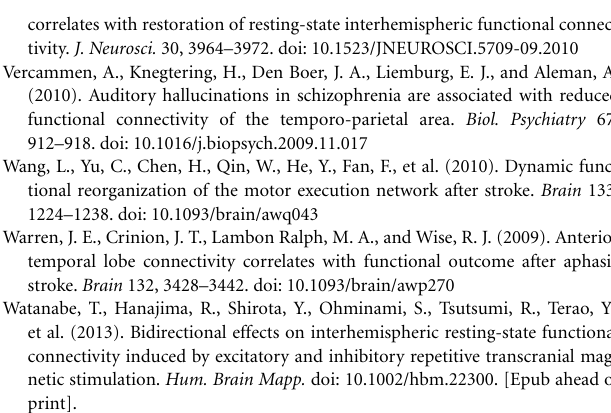
figure-8 coils in TMS: calculation of focality and efficiency. Clin. Neurophysiol. 115, 1697–1708. doi: